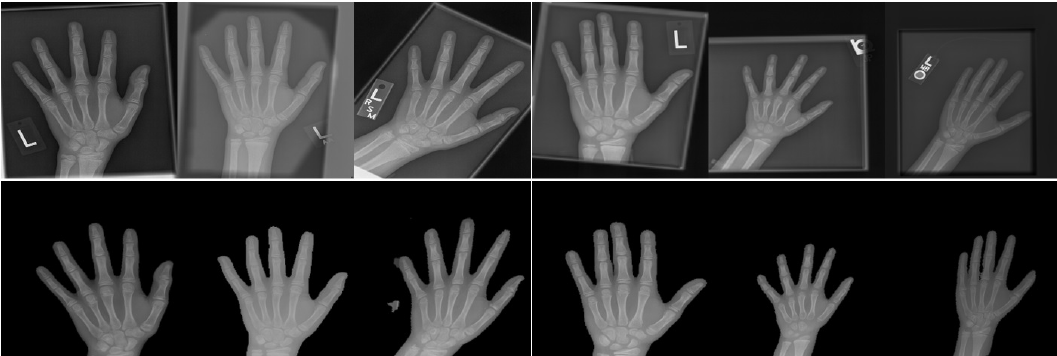
Figure 6. Some output samples of the X-ray image that have passed through the image registration process. The first-row samples illustrate the original input images, while the second-row samples illustrate the image that has been